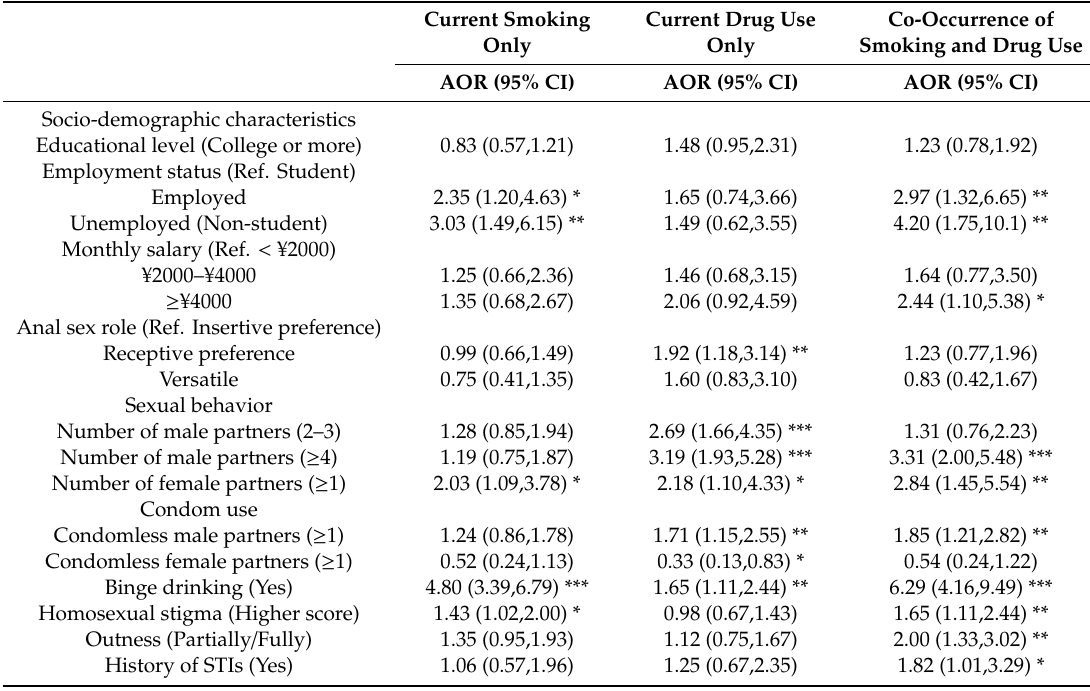
Table 4. Adjusted multinomial analyses (as MSM with neither current smoking nor drug use as reference); factors associated with cigarette smoking and drug